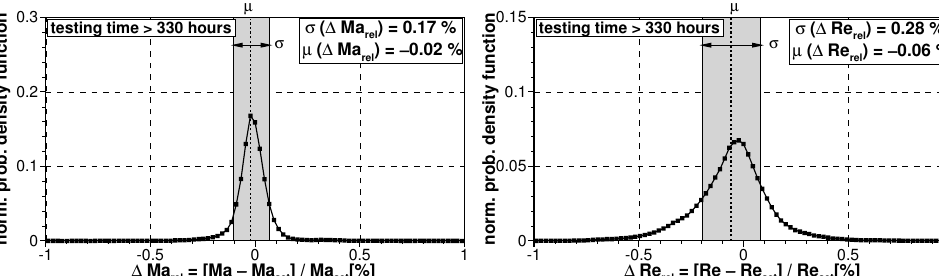
Figure 6. Statistics of the operating point stability for Mach number ( left ) and Reynolds number ( right ) extracted from the continuous logs for more than 330h of HGK